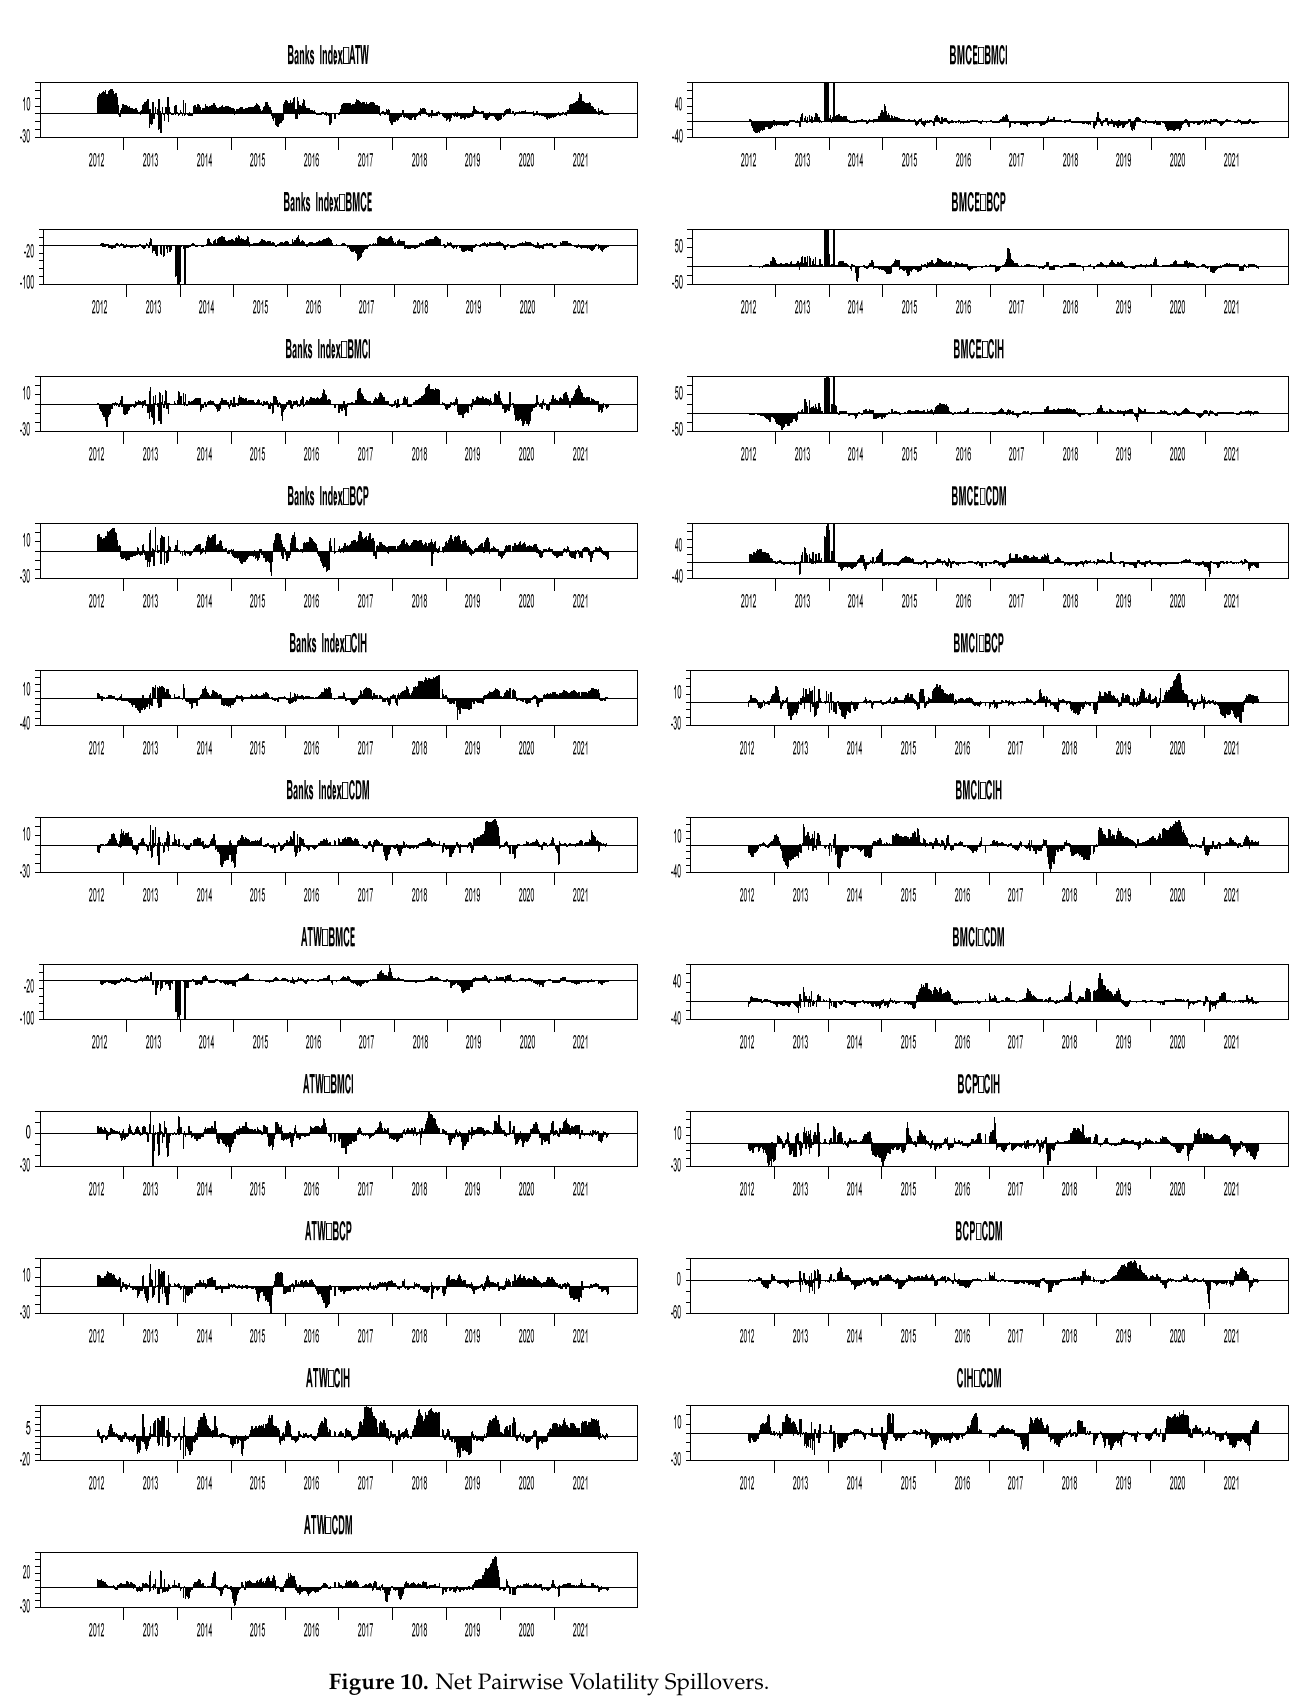
Figure 10. Net Pairwise Volatility Spillovers.